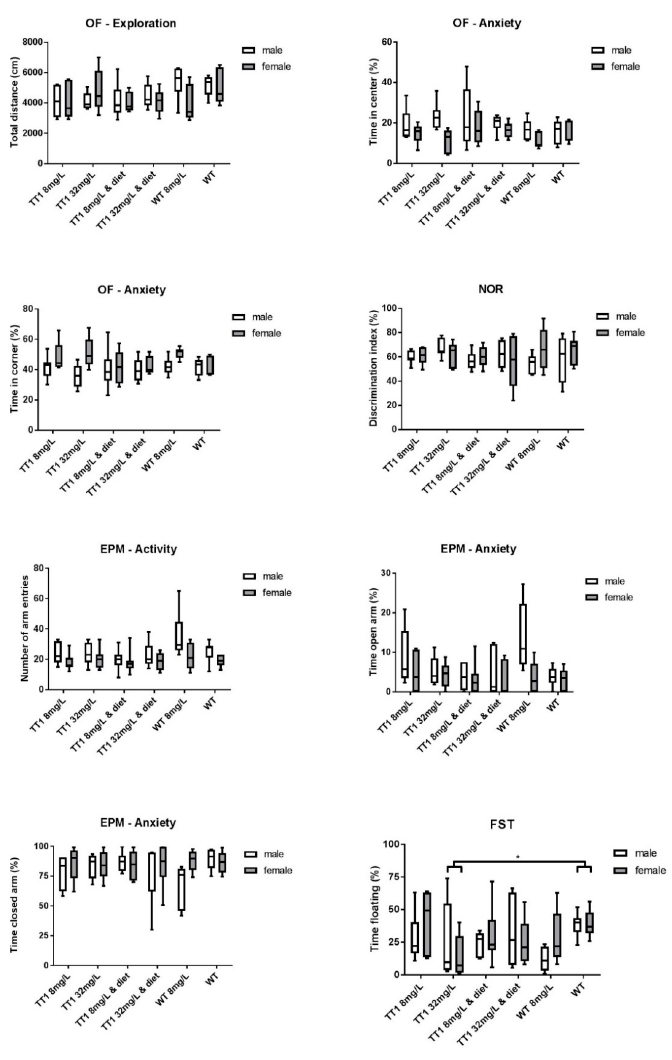
Figure 5. Behavioral outcomes on the open field (OF), novel object recognition (NOR), elevated plus maze (EPM) and forced swim test (FST) comparing the different treatment groups. Although all mice underwent behavioral testing, the number of mice vary between n = 10 and n = 14 for all treatment groups in the different tests. Untransformed data are expressed as boxplots (min–max whiskers). * p < 0.05 (two-sided).